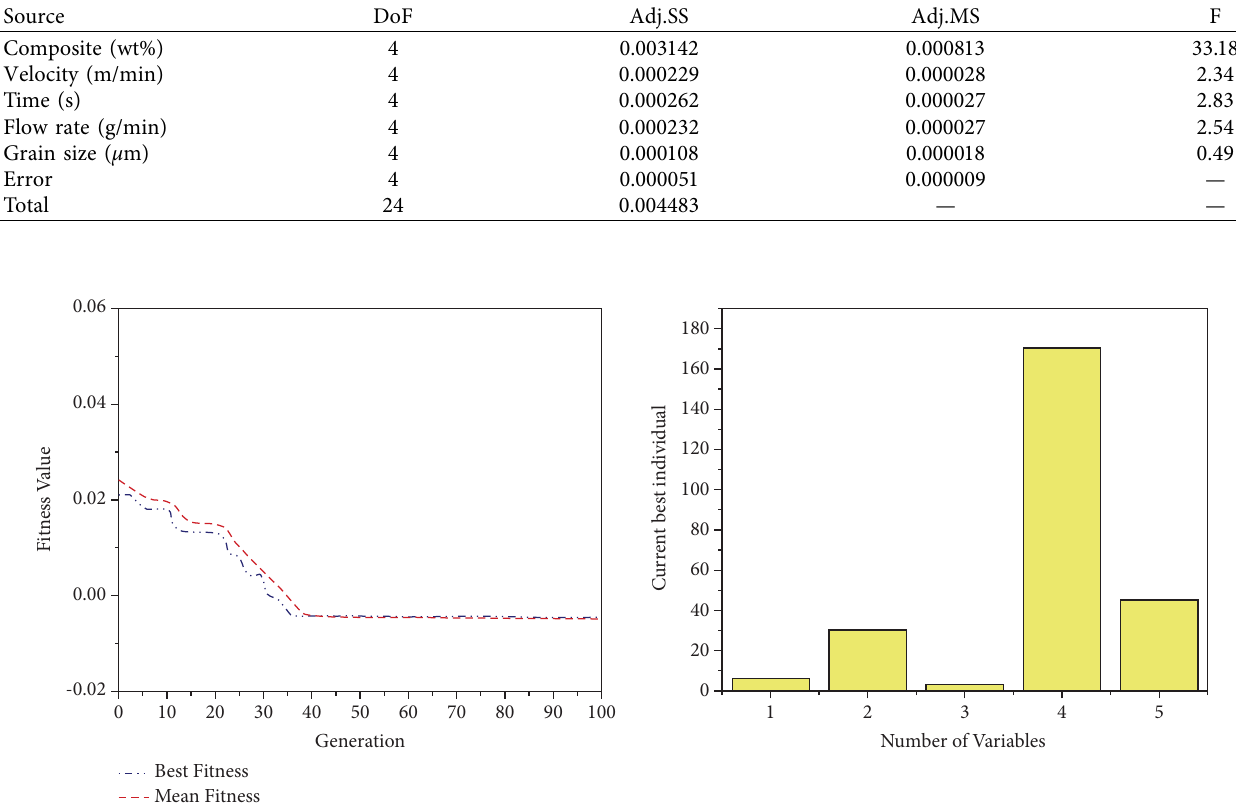
Table 11: ANOVA results (abrasive wear).